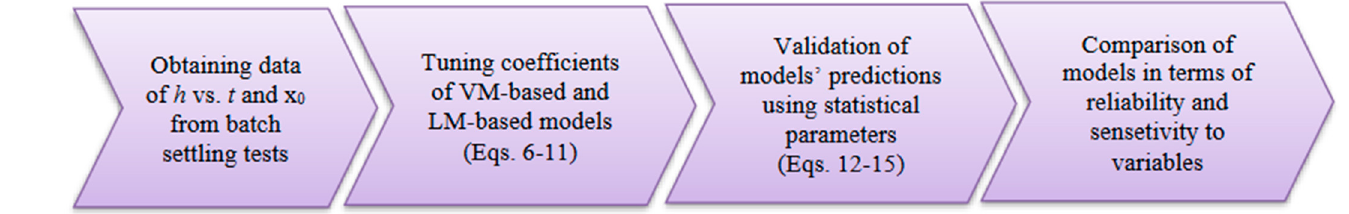
Figure 3. Main steps of the modeling process.